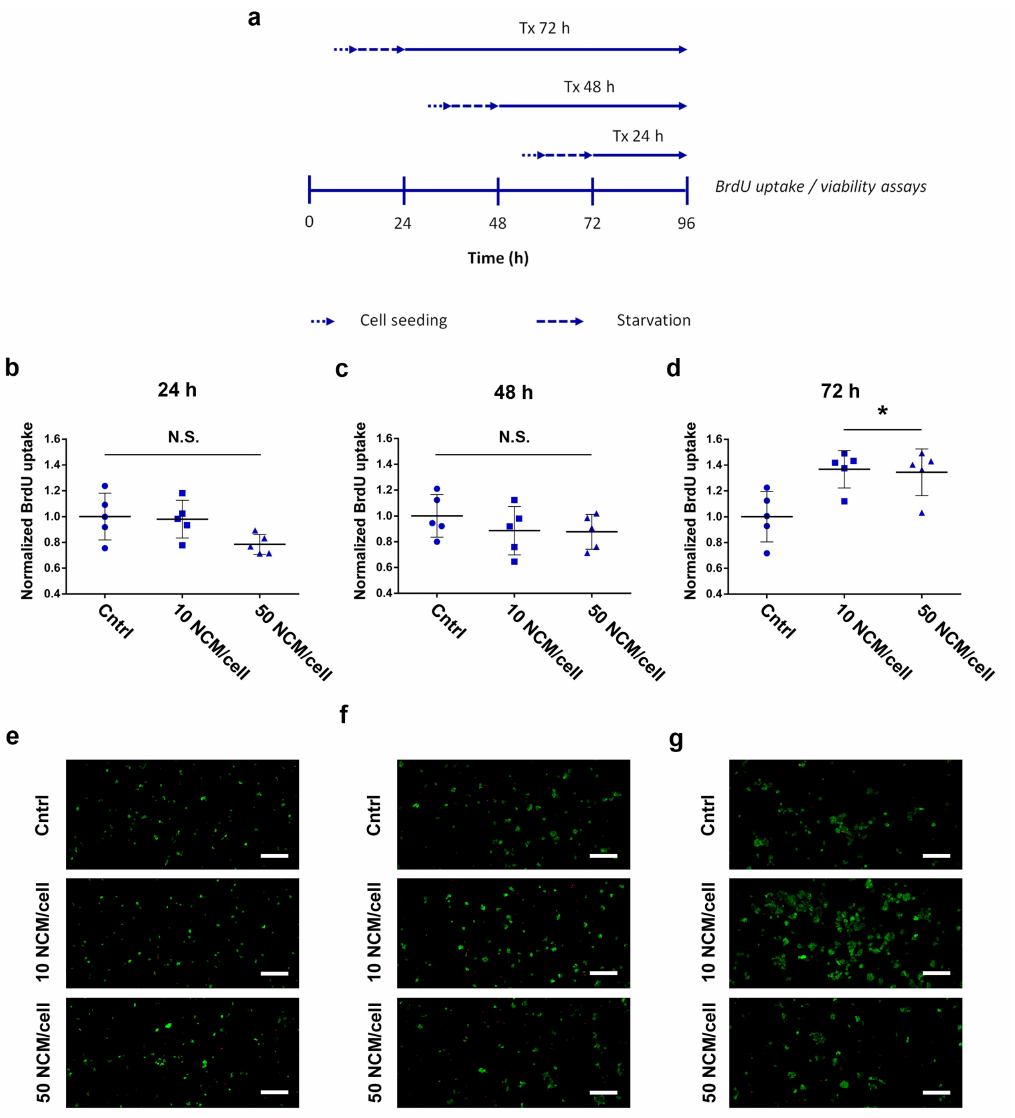
Figure 3. NCM proliferative response in HaCaT. ( a ) Experimental design to assess BrdU uptake ( b – d ) and cell viability ( e – g ) after treatment with NCMs at di ff erent doses and exposure times; ( b – d ) BrdU uptake in HaCaT cells after 24 h ( b ), 48 h ( c ) and 72 h ( d ) of treatment; ( e – g ) Representative confocal fluorescence images of cells probed with the live / dead viability kit (Green, living cells; Red, dead cells) 24 h ( e ), 48 h ( f ) and 72 h ( g ) after treatment with NCMs.*, p < 0.05; N.S., nonsignificant ( p > 0.05). Scale bars, 200 µ m. Cntrl, control with no NCM